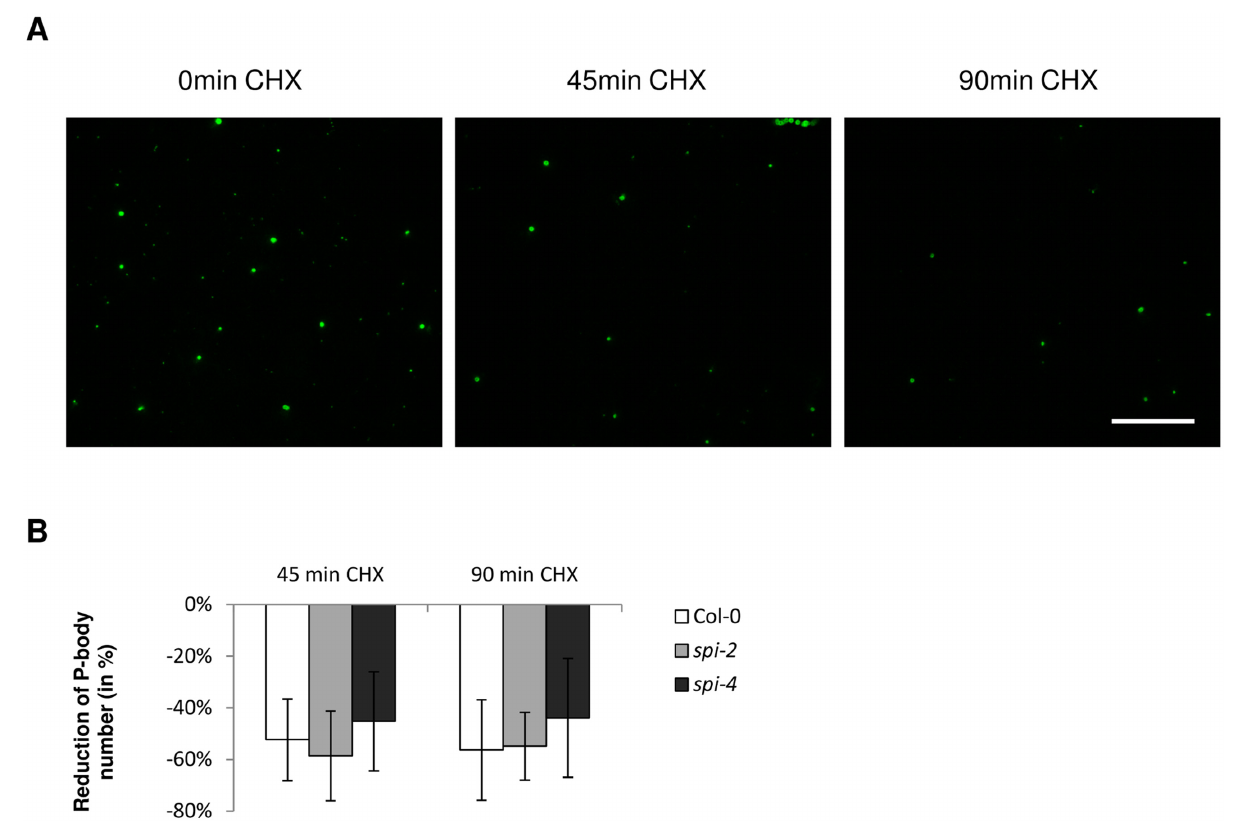
Fig 4. Blocking translation leads to a reduction of P-body number. Changes of P-body number were analyzed in whole leaf areas of transgenic plants expressing DCP1-YFP. (A) Whole leaf areas are presented before (0 min) and after continuous CHX treatments (45 min and 90 min). Scale bar: 50 μ m. (B) Reduction of P-body number (in %) relative to untreated samples (time point 0) determined 45 min and 90 min after CHX treatment. Data denote the average from seven biological replicates. SD values represent standard deviations. No statistical differences were found between wild-type and spi mutants (Two- tailed student ’ s t